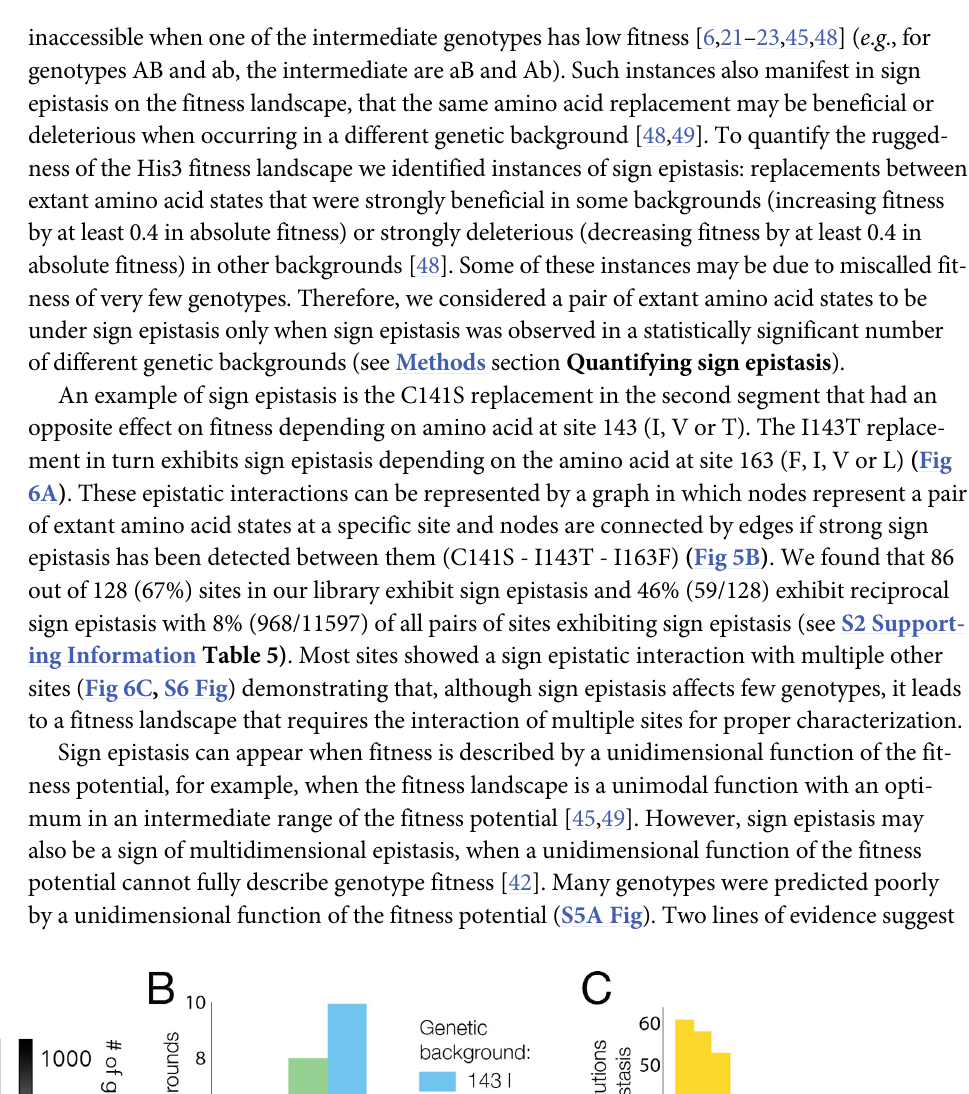
corresponds to an independent optimization of model parameters. e, Fitness as a function of two fitness potentials (black dots, measured fitness is depicted in orange).